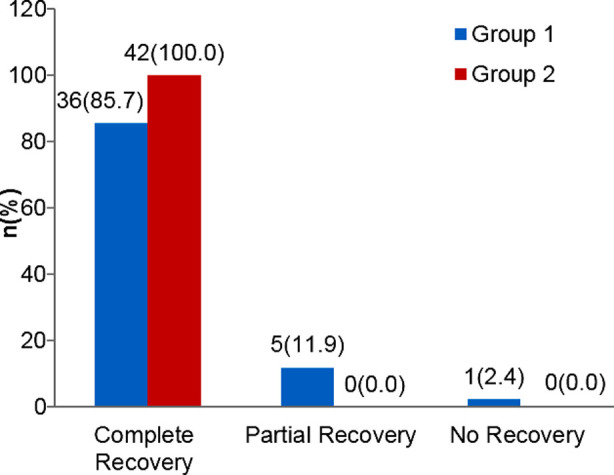
Severity of bed wetting at 12thweek of treatment in children of different groups.